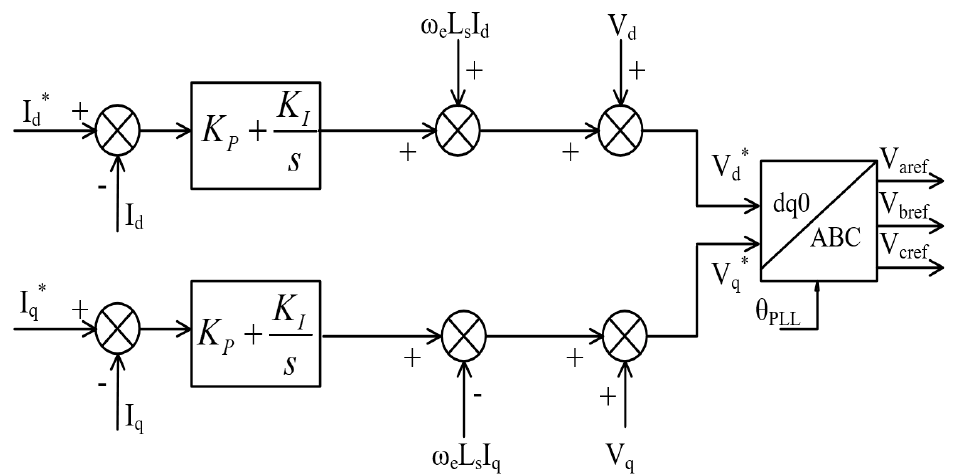
Figure 7. A logic diagram of the health status check controller.